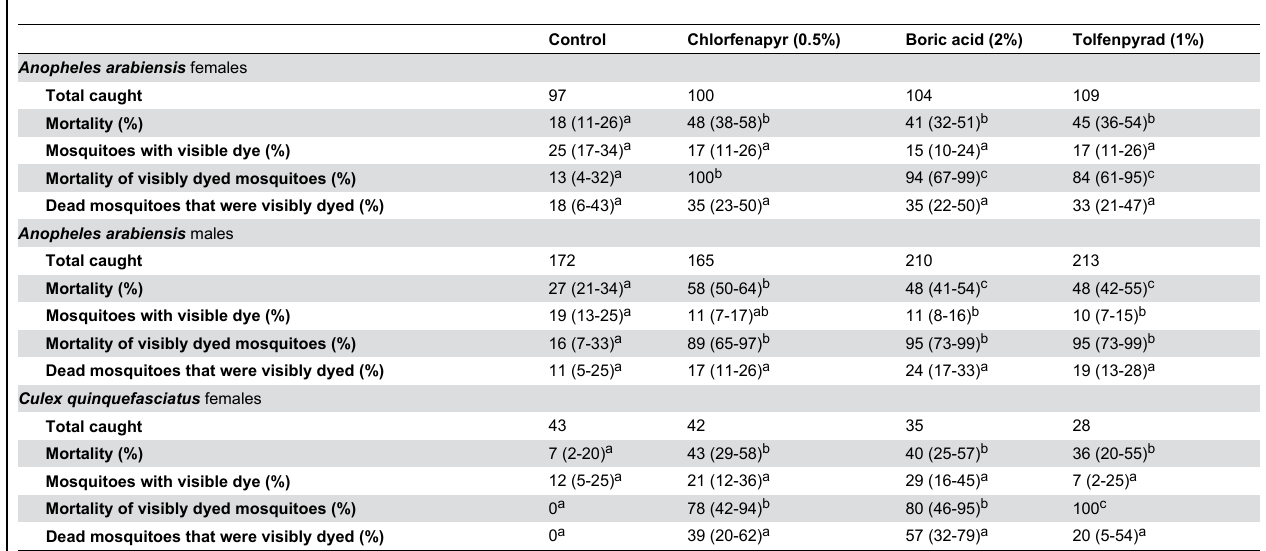
Table 2. Results of experimental hut trial of three toxic sugar baits against An. arabiensis and Cx. quinquefasciatus . Numbers of female mosquitoes tested, the percentage dying, the percentage dyed with a red dye, and the percentage of dyed mosquitoes that died (and 95% confidence intervals) are